Question: State the chart type depicted above.
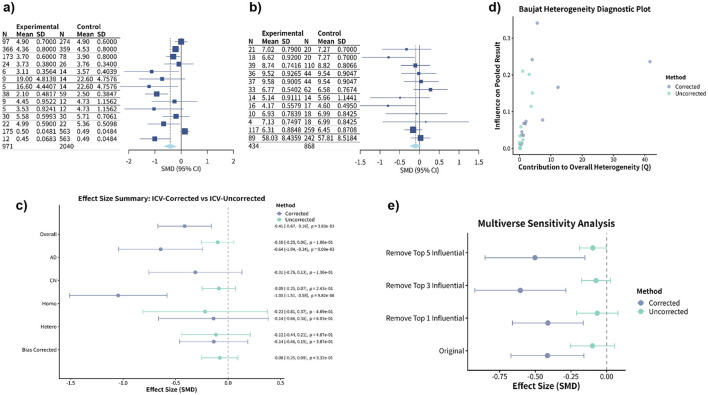
Answer: forest